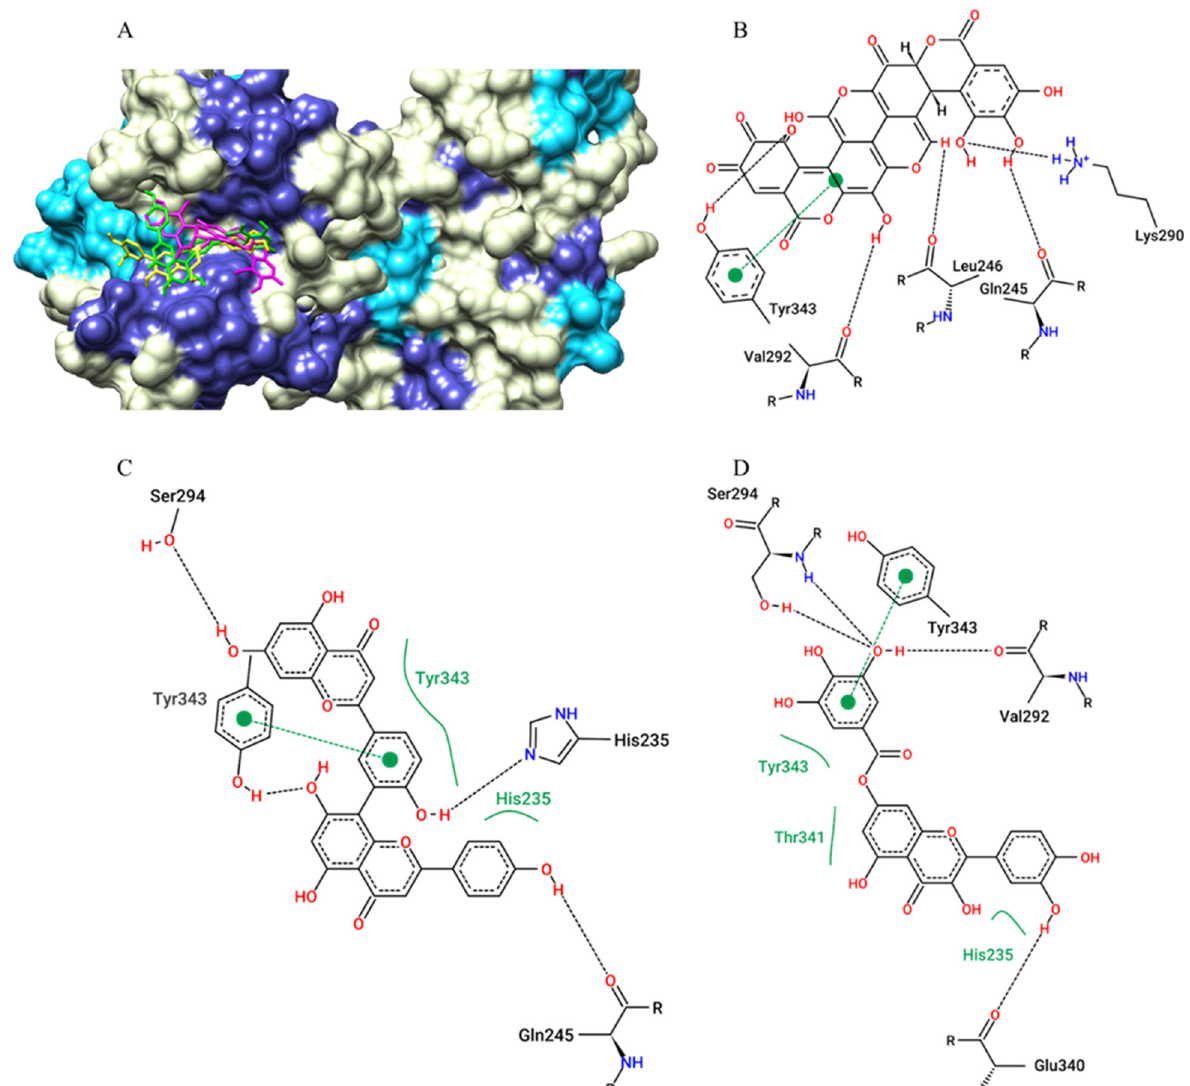
Figure 5. Surface representation of plant metabolites docking positions on the SARS-CoV-2 NSP15 endoribonuclease active site, with amentoflavone (green), 7-O-galloylquercetin (yellow), and gallagic acid (magenta) ( A ). Contacts of SARS-CoV-2 NSP15 endoribonuclease active site residues with gallagic acid ( B ), amentoflavone ( C ), and 7-O-galloylquercetin ( D ) are depicted in two dimensions. Dashed black lines represent hydrogen bonds, while full green lines represent van der Waals interactions. dashed green line represent π - π stacking.